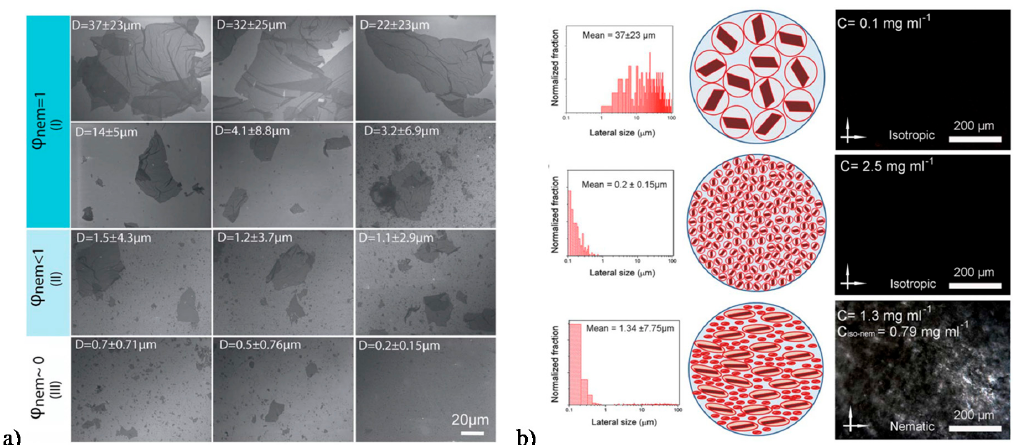
Figure 8. ( a ) SEM images examining the effect of ultra-large GO sheet size (D is lateral dimension) on wet-spinning capability, where (I), (II), and (III), represent spinnable, slightly spinnable, and non-spinnable. ( b ) Isotropic and non-spinnable ultra-large sheet (top) and small sheet GO (middle) can be combined to form a nematic liquid crystalline dispersion suitable for fiber spinning. Modified with permission from Jalili, R.; Aboutalebi, S.H.; Esrafilzadeh, D.; Konstantinov, K.; Razal, J.M.; Moultona,